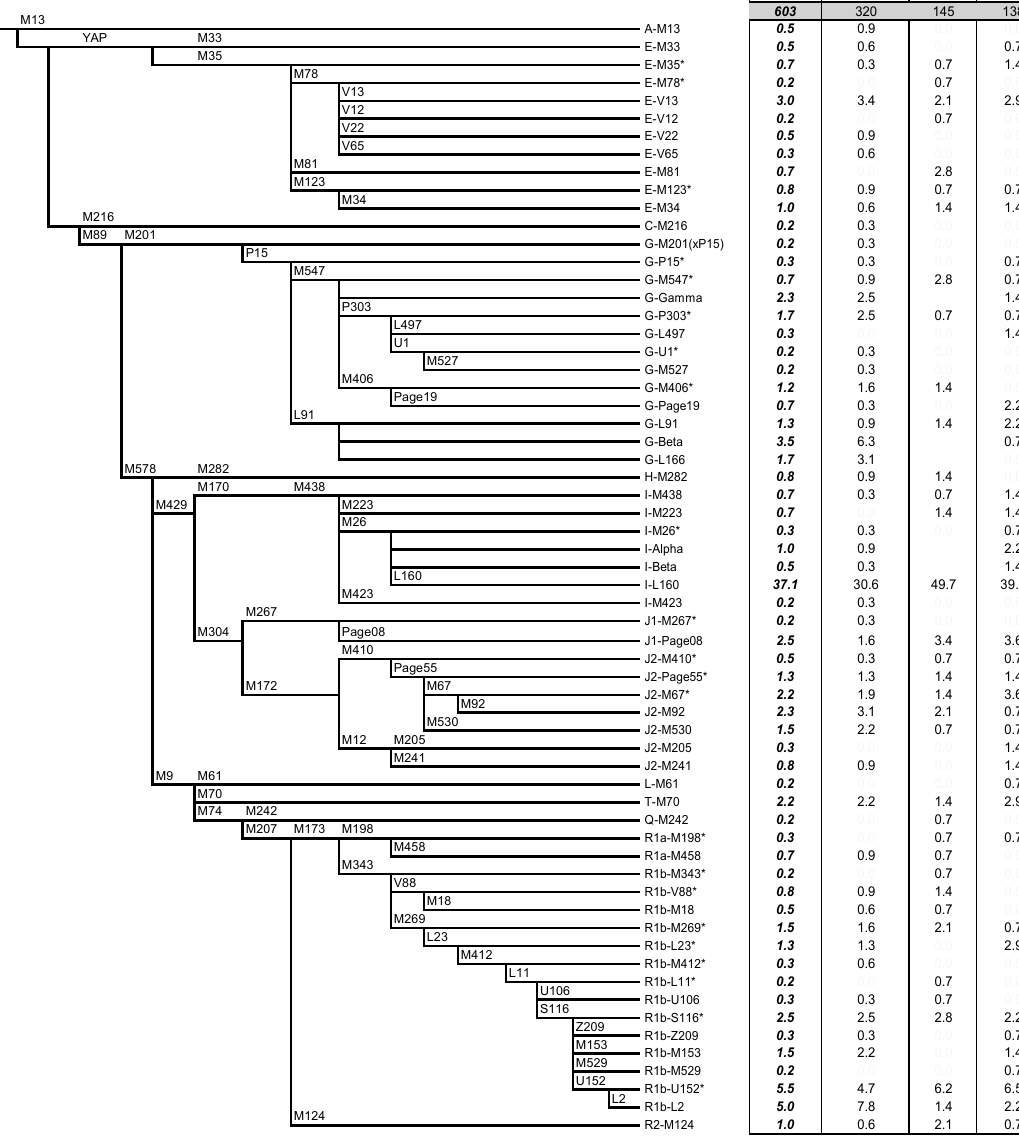
Figure 1. Phylogenetic tree of Y-chromosome haplogroups and their frequencies (as percentage) in the whole Sardinian sample and in the three main geo-cultural regions of the island. Names of markers are indicated above the lines; the lengths of branches are not drawn to scale for better readability. Asterisk (*) indicates a paragroup: group of Y chromosomes defined by the derived state of the main haplogroup but by any downstream mutation.